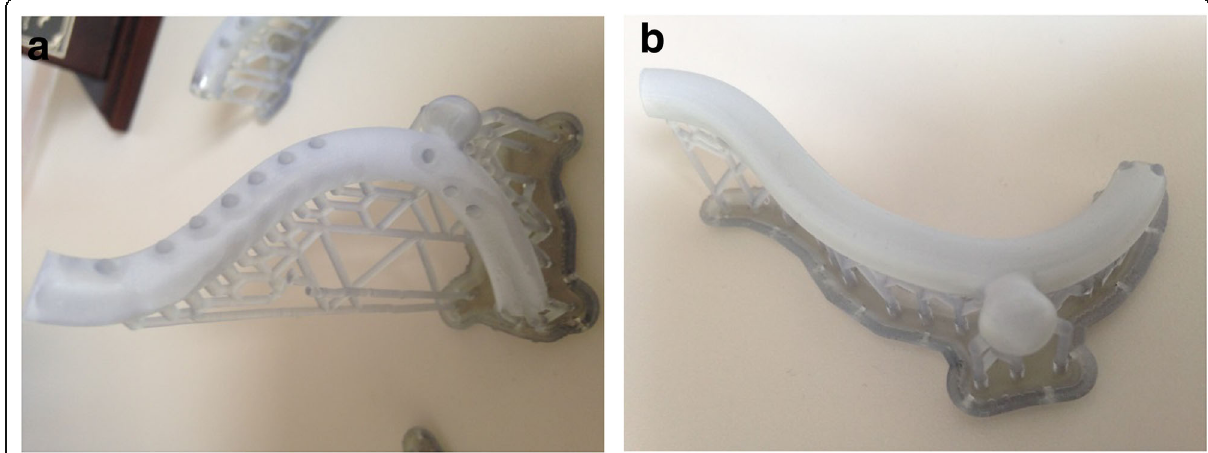
Fig. 5 Example of a vessel print with support structures. When the vessel is printed in the anatomically correct orientation ( a ), it is running perpendicular to the printing surface and thus a lot of support material is required. When re-oriented and printed parallel to the printing surface ( b ), less support is